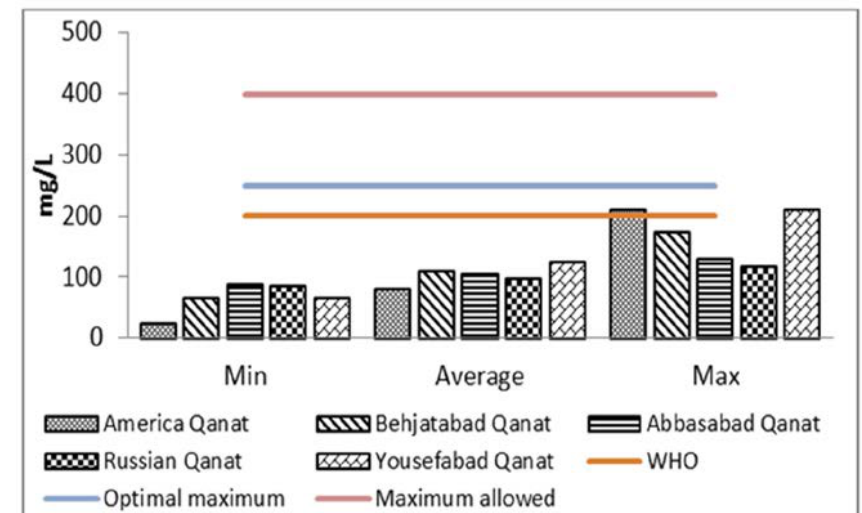
Fig. 12: Chlorine level and its comparison with the WHO and the National Standard of Iran